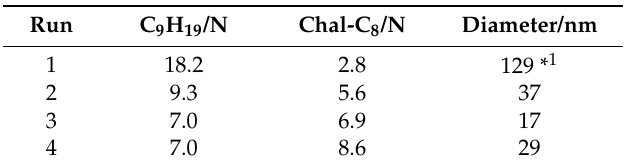
Table 3. The number of introduced n -nonyl and chal-C 8 moieties in block copolymers and the size of the prepared polymeric